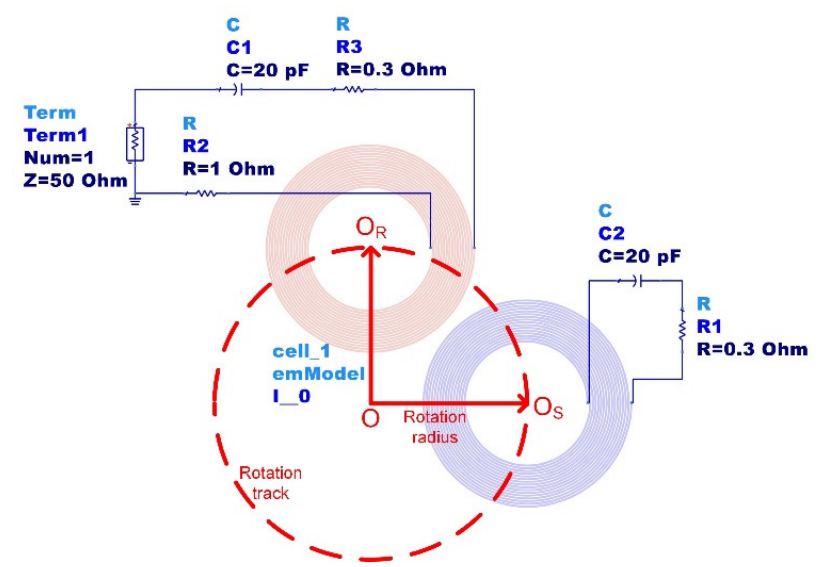
Figure 2. S chematic diagram of the ADS simulation. Table 2. Circuit simulation parameters.